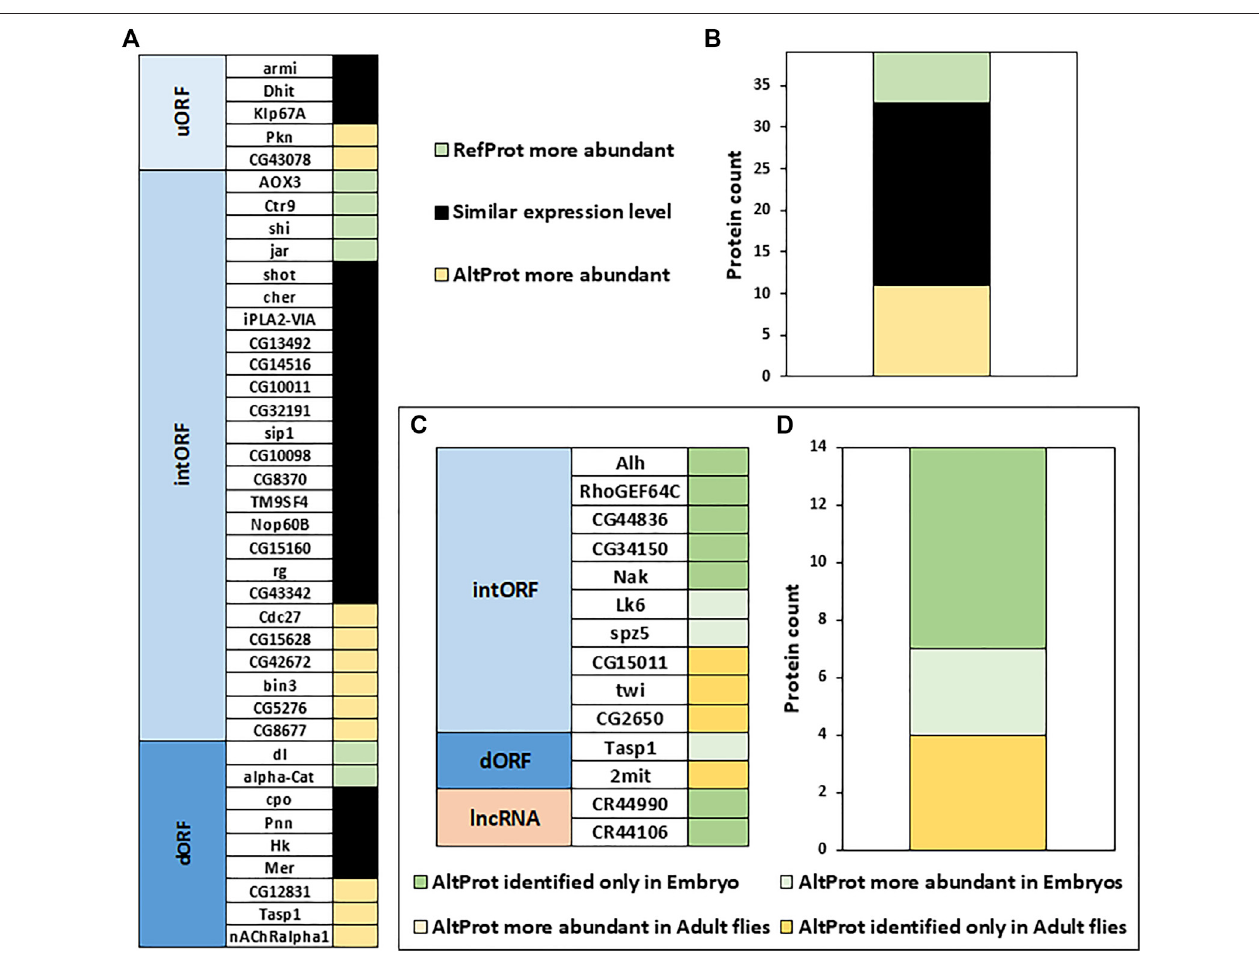
FIGURE 6 | Alternative proteins can be more abundant than their corresponding canonical proteins and their expression is developmentally regulated. (A) . Comparison of the approximation of the relative abundance measured for each couple of canonical (RefProts) and alternative (AltProts) proteins for each type of ORF usingtheintensitybasedabsolutequanti fi cationapproach(iBAQ).AnAltProt/RefProtisconsideredmoreabundantthanitscounterpartifitsiBAQvalueisatleast10-fold higher. (B) .Graphshows theprotein countsofAltProts aremore abundant thanRefProts, RefProts aremoreabundantthan AltProts,and similar expression levels between AltProts and RefProts. (C) . Fold change between embryo and adult fl y was calculated for each AltProt and normalized by the maximum intensity between the twosamples.AnAltProt/RefProtisconsideredmoreabundantinaspeci fi cdevelopmentalstageifitsintensityvalueisatleast3-foldhigher. (D) .Graphshowstheprotein counts of AltProts are more abundant, or identi fi ed only, in embryo, or in adult fl ies.